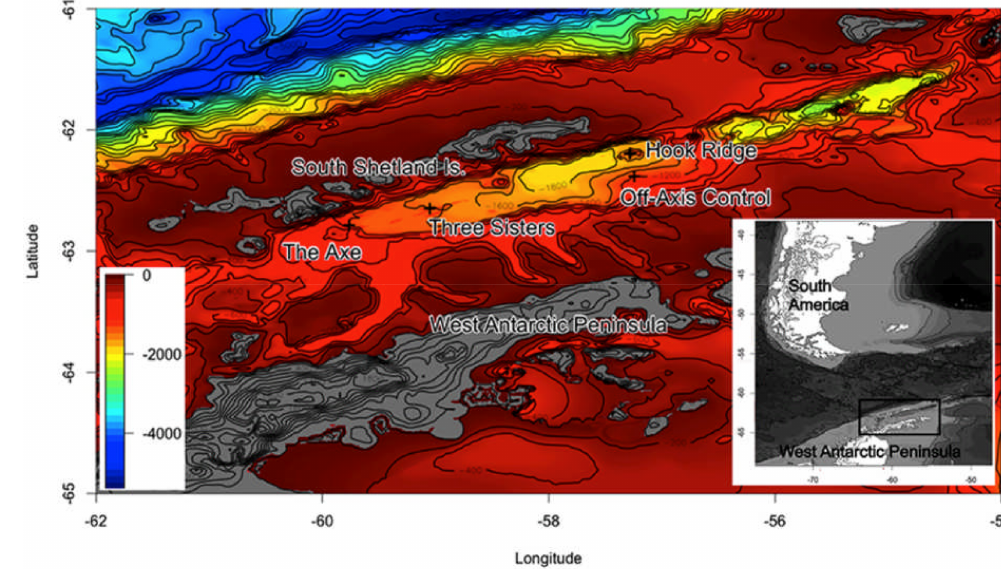
Figure 1. Sampling sites (after Bell et al., 2016b). Table 1. Site descriptions and associated